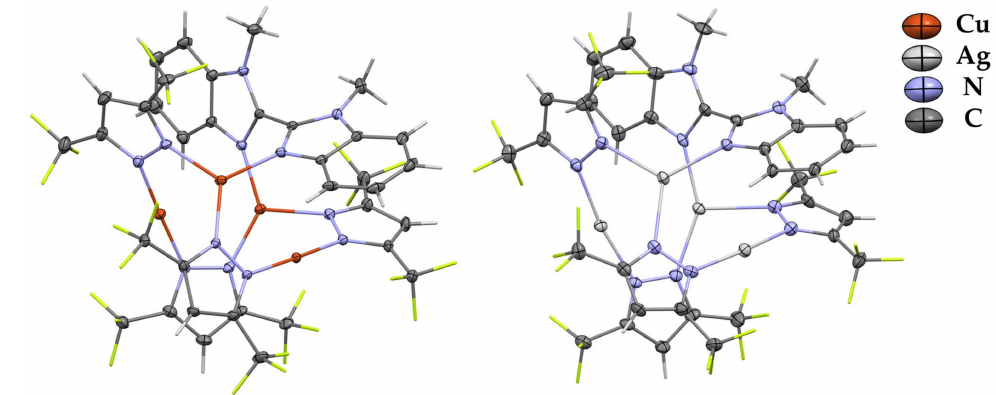
Figure 2. XRD structures of complexes 2 and 4 with thermal ellipsoids set at the 30% probability level. Hydrogen and fluorine atoms are sticks for